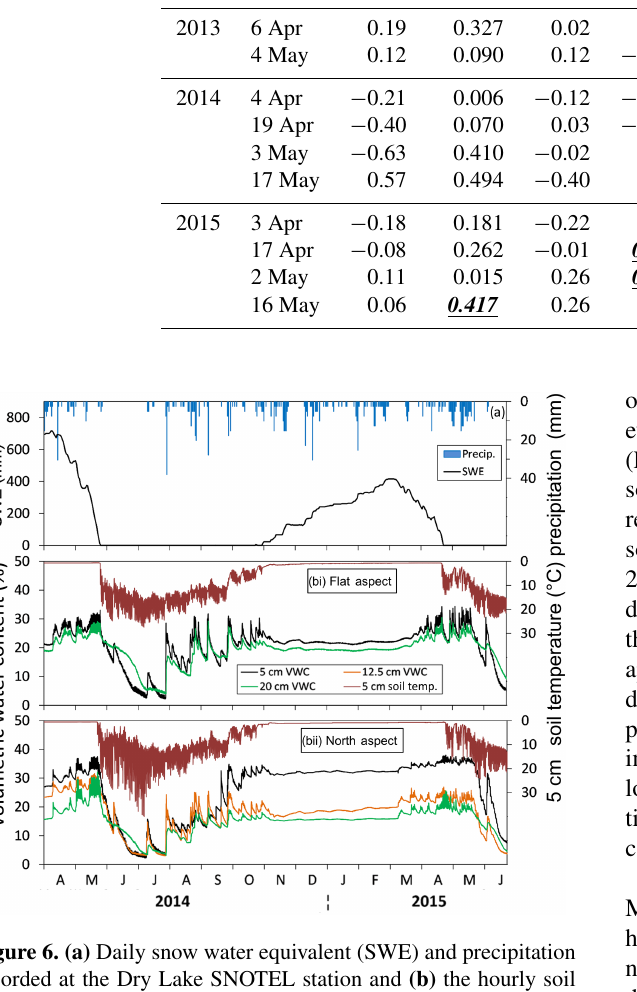
Table 2. Results of pattern analysis of near-surface soil moisture measurements based on slope angle, northness (North.), elevation (Elev.), SWE, change in SWE ( (cid:49) SWE), SWE on first survey of the year, and near-surface soil moisture (VWC) on first survey of the year. Significant values are shown in italic; figures in bold have p values of less than 0.05 and those underlined have p values of less than 0.01. Slope North. Elev. SWE (cid:49) SWE First SWE First VWC